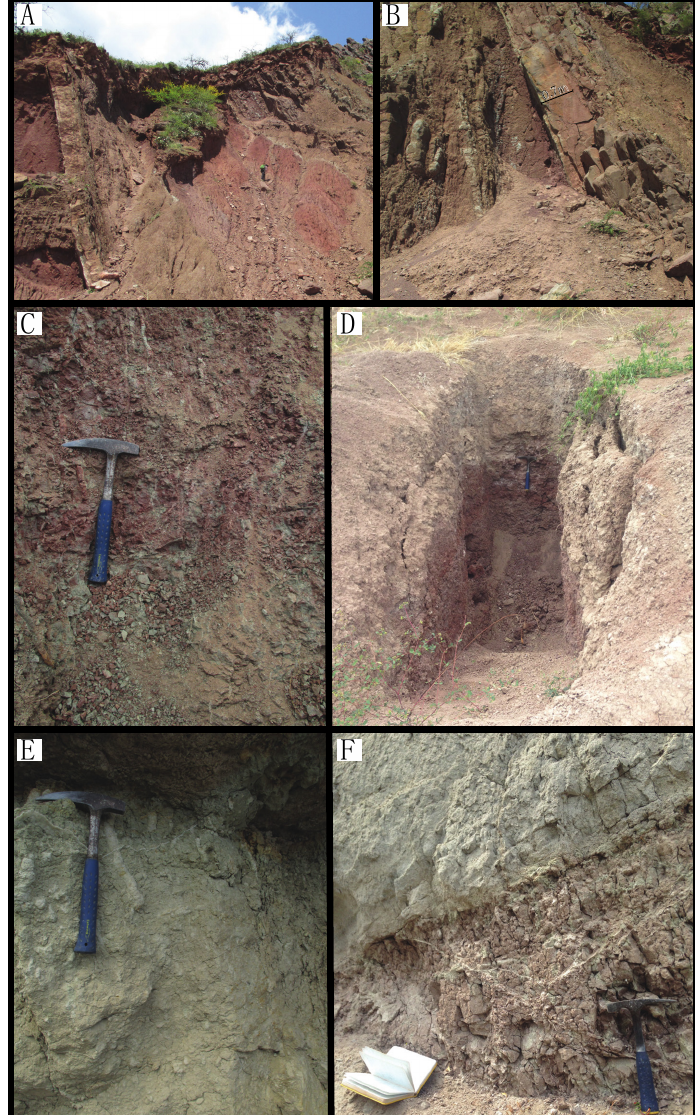
Figure 4. Paleosols photographs from the Fundo El Triunfo Formation ( A , B ) and the Sambimera Formation ( C – F ).